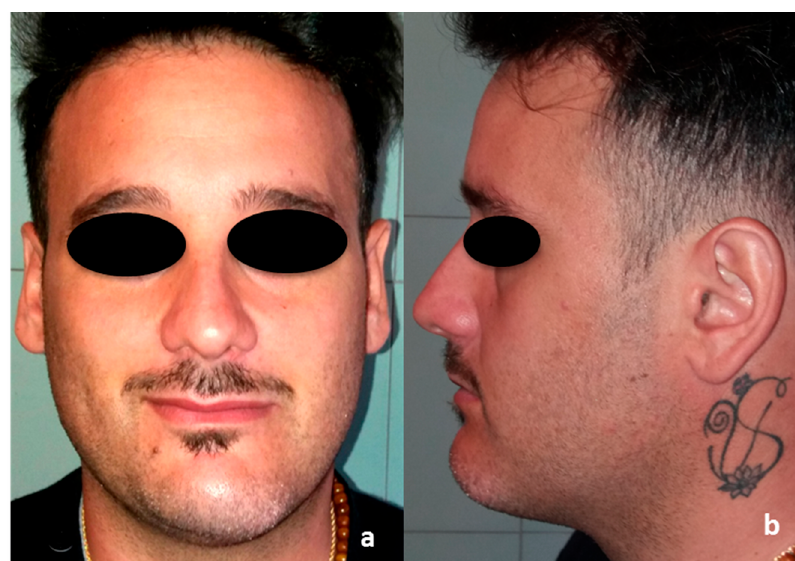
Reports 2020 , 3 , x